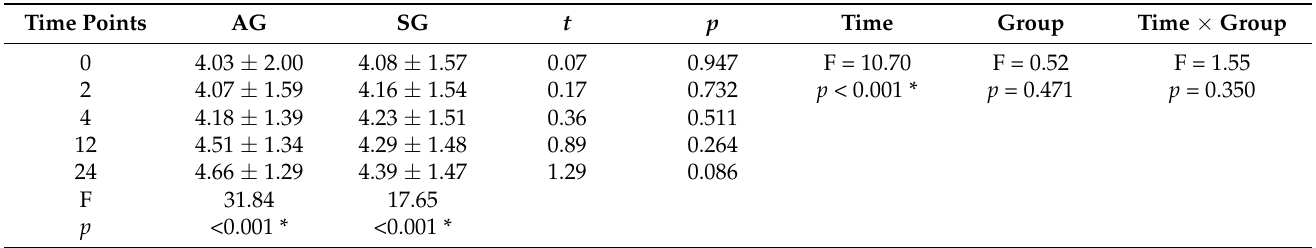
Table 5. Comparison of time and group on log transformed BDNF concentration.